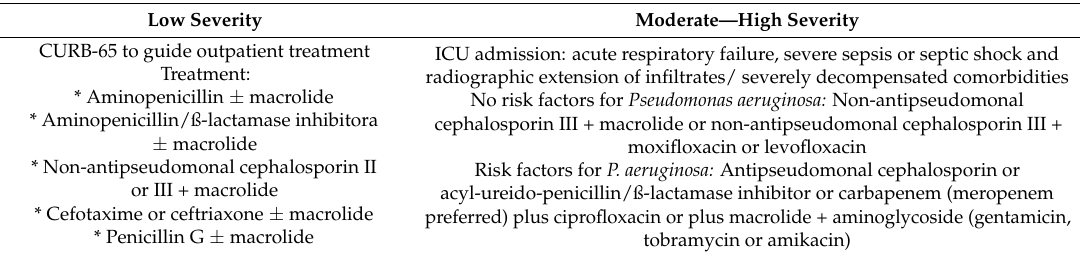
Table 6. ERS/ESCMID Guidelines for the Management and Treatment of Community-Acquired Pneumonia